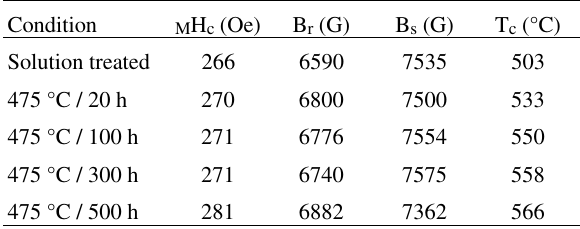
Figure 2. SEM composition image of the sample aged for 500 h at 475 °C, etched with 10%HNO 3 +0.05%HF solution. Table 2. Magnetic Properties: coercivity ( M H c ), residual induction (B r ), saturation induction (B s ) and magnetic transition temperature (T c